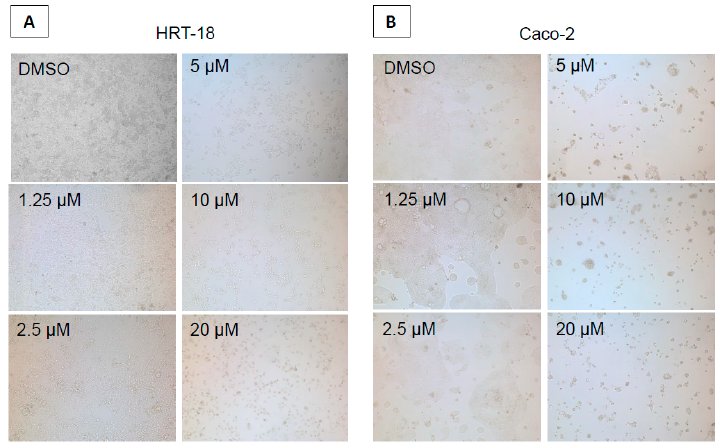
Figure 1. Sorafenib treatment for 72 h led to a dose-dependent decrease of viable cells in both cell lines. ( A ) The KRAS-mutated HRT-18 cell line and ( B ) The KRAS wild-type Caco-2 cell line (400× magnification).